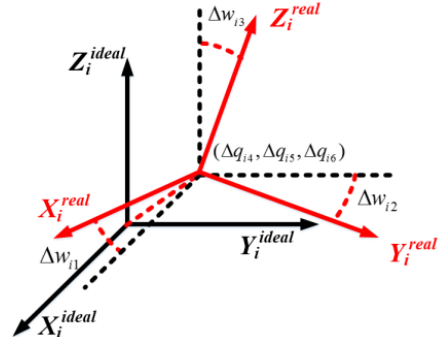
Figure 2. Definition of kinematic errors for link i .